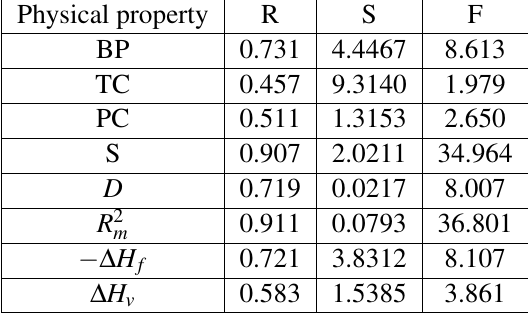
Table 8 Statistical parameters for the QSPR model (5).